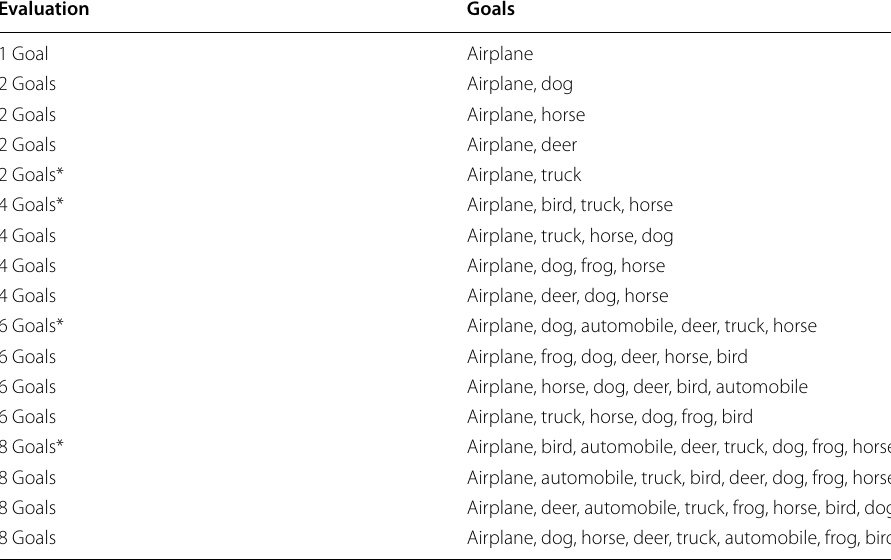
Table 1 Goals for evaluation